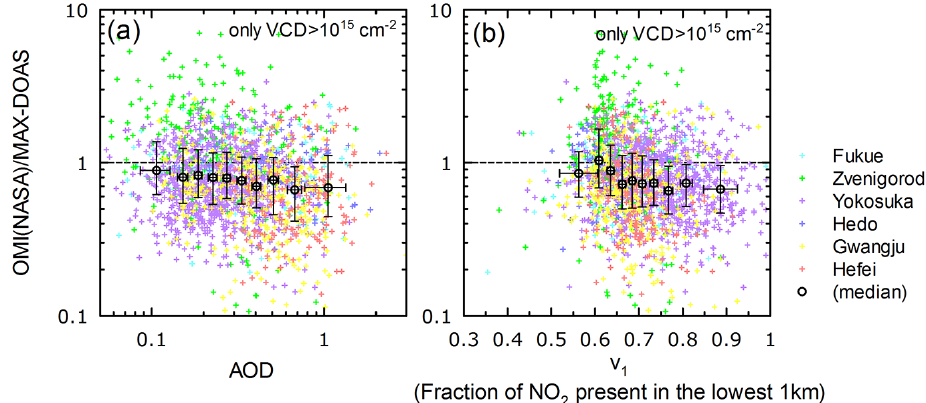
Figure 10. OMI(NASA)/MAX-DOAS ratios for TropoNO2VCD were plotted against (a) AOD at 476nm, observed with MAX-DOAS, and (b) v 1 , a retrieved parameter defining the fraction of NO 2 present in the lowest 1km. Black circles and error bars represent the median ratios and 1 σ ranges for the 10 bins sorted by AOD and v 1 , respectively.